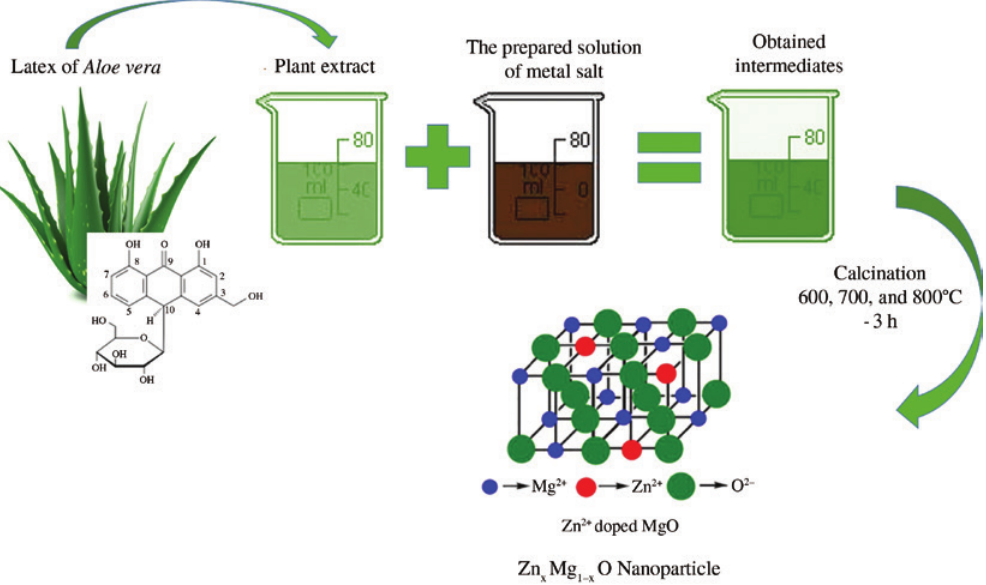
Figure 5: Schematic of effect of C-glycosyl constituents in the Aloe vera latex in synthesis of Zn 2 + doped in MgO